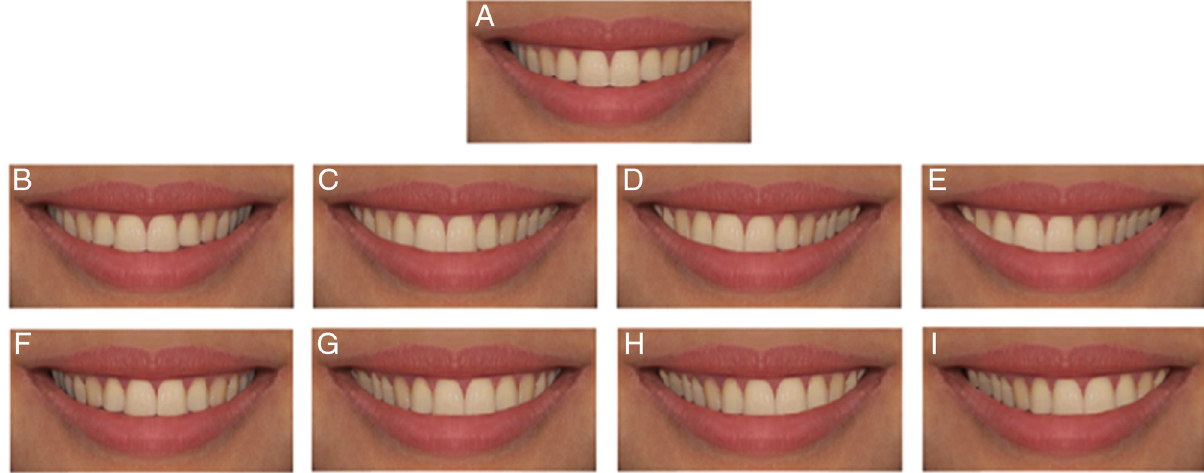
Figure 1. The study photograph and eight modified smile photographs. The dental midline was shifted to the left and right segments gradually. A. Dental Midline In Place (DML0). B. Shifted Dental Midline 1 mm Right (DML1R). C. Shifted Dental Midline 2 mm Right (DML2R). D. Shifted Dental Midline 3 mm Right (DML3R). E. Shifted Dental Midline 4 mm Right (DML4R). F. Shifted Dental Midline 1 mm Left (DML1L). G. Shifted Dental Midline 2 mm Left (DML2L). H. Shifted Dental Midline 3 mm Left (DML3L). I. Shifted Dental Midline 4 mm Left (DML4L).